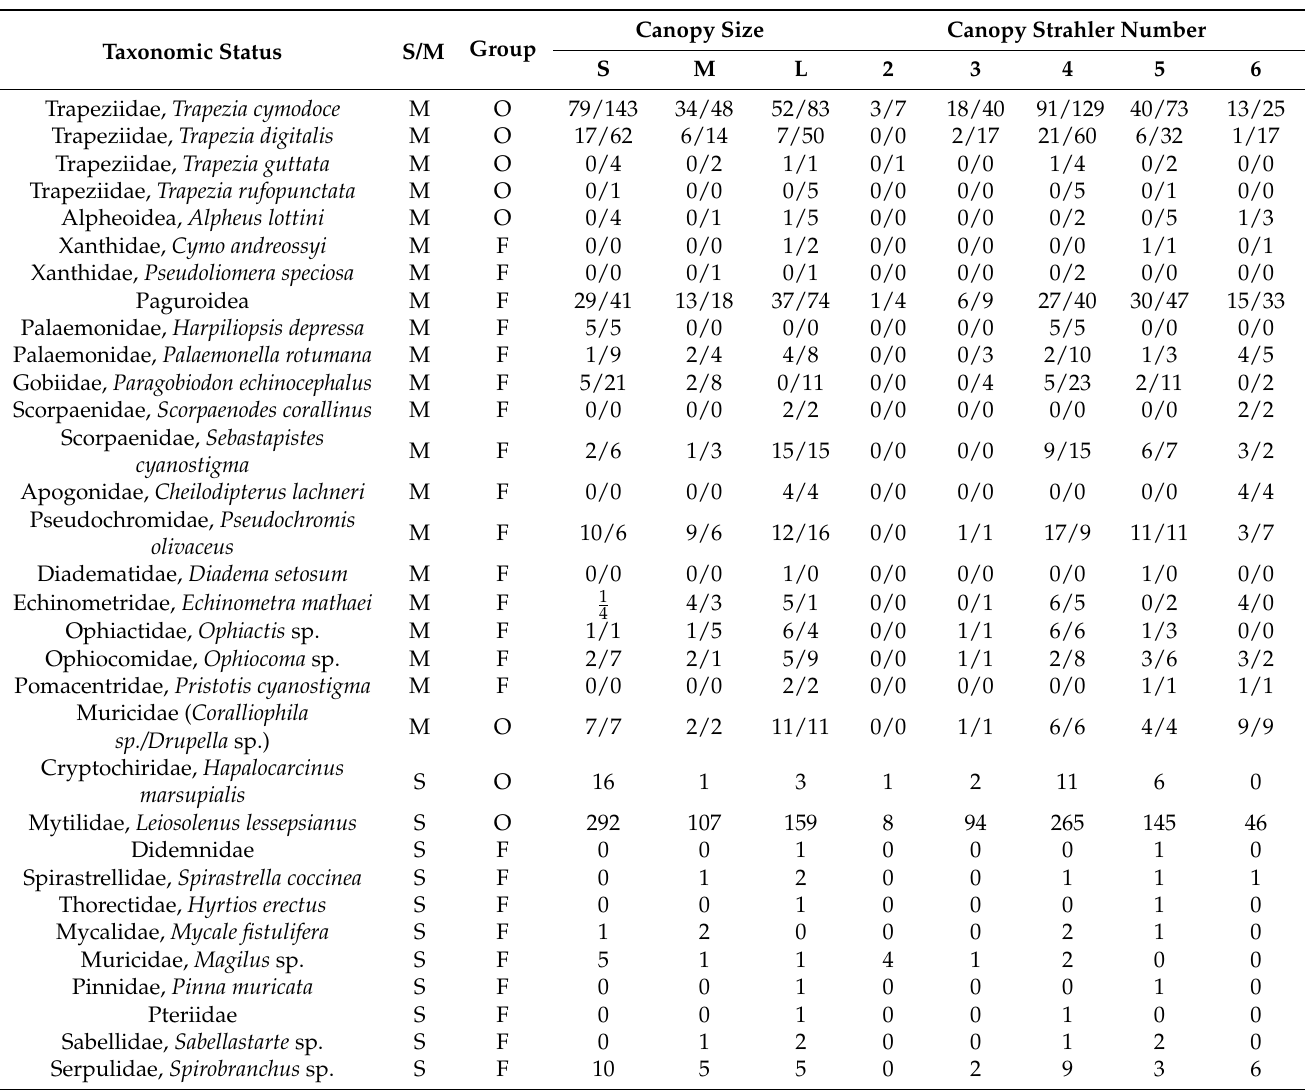
Table 1. Total abundance of Stylophora pistillata dwelling species recorded for sessile species and for mobile species at day and night paired surveys ( n = 114) as per the canopy volume size (S: small; M: medium; L: large) and the canopy’s Strahler number (2–6), backslash indicate day/night